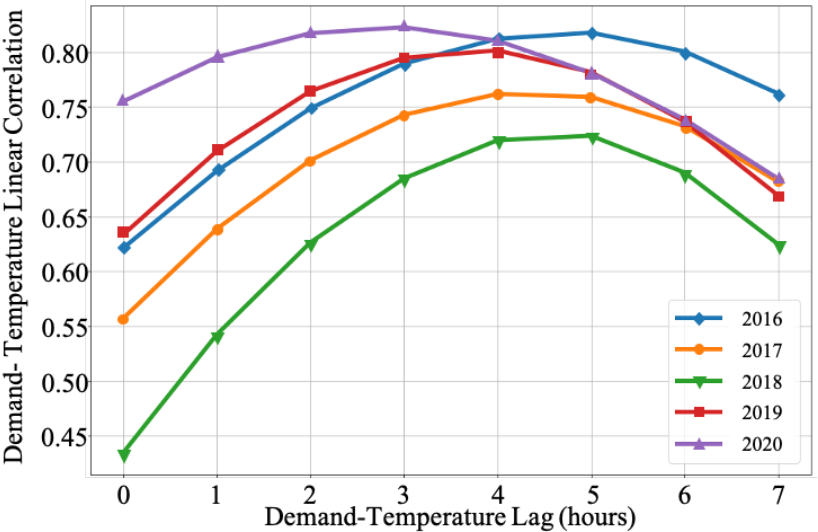
Figure 7. The correlation between the electricity demand and temperature lags in the month of April from 2016 to